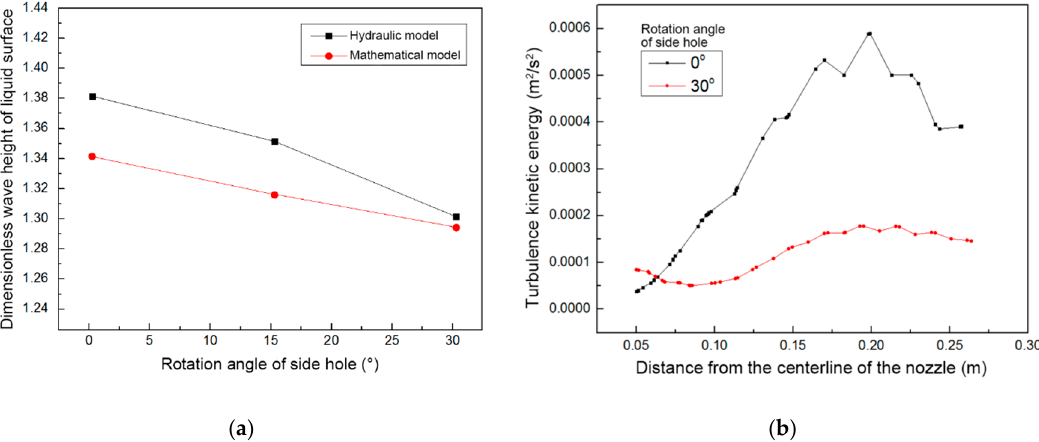
Figure 14. The effect of rotation angle of side holes to liquid surface of the mold. ( a ) Liquid wave height; ( b ) Turbulence kinetic energy of liquid surface.